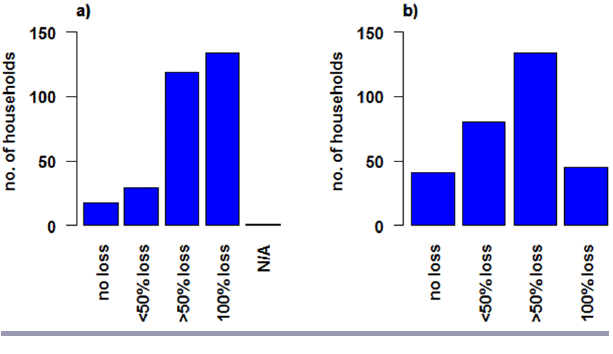
Fig. 2 . (a) Rice crop losses reported by households following the 2008 floods (N/A refers to households not cultivating rice in 2008) and (b) rice crop losses reported by households following cyclone Phailin in 2013.